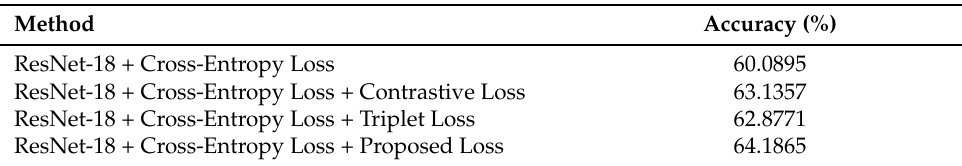
Table 5. Comparison of different loss functions.